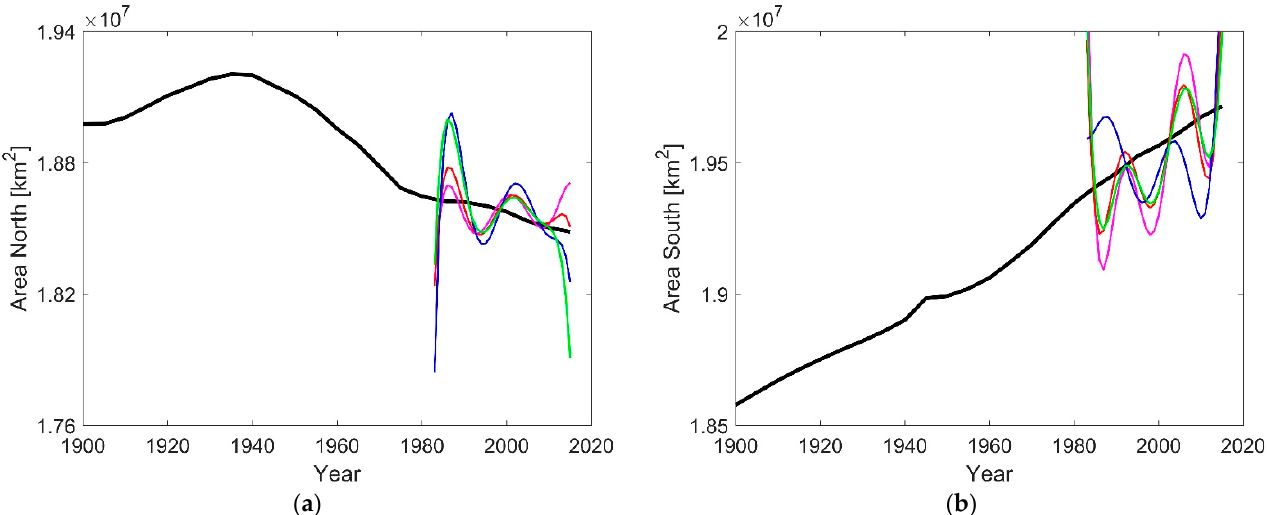
Figure 9. ( a ) Northern and ( b ) southern areas of auroral zone plus polar cap (thick black lines) estimated with a geomagnetic core field model (IGRF 12; Thébault et al., 2015) by Zossi et al. (2020) and corresponding estimates from filtered AB data (this study) considering the following first filters: AB data for 0 < Kp ≤ 2 (magenta), 2 < Kp ≤ 4 (red), 4 < Kp ≤ 6 (blue), annual means of the residuals from the linear regression with Kp (green).